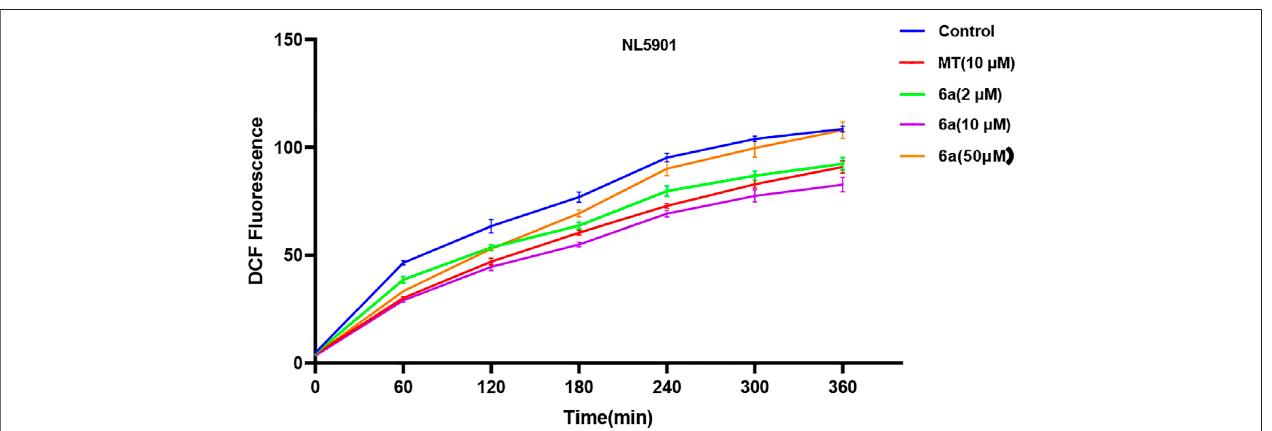
FIGURE 4 | Effect of 6a on the ROS level of the transgenic nematode NL5901.